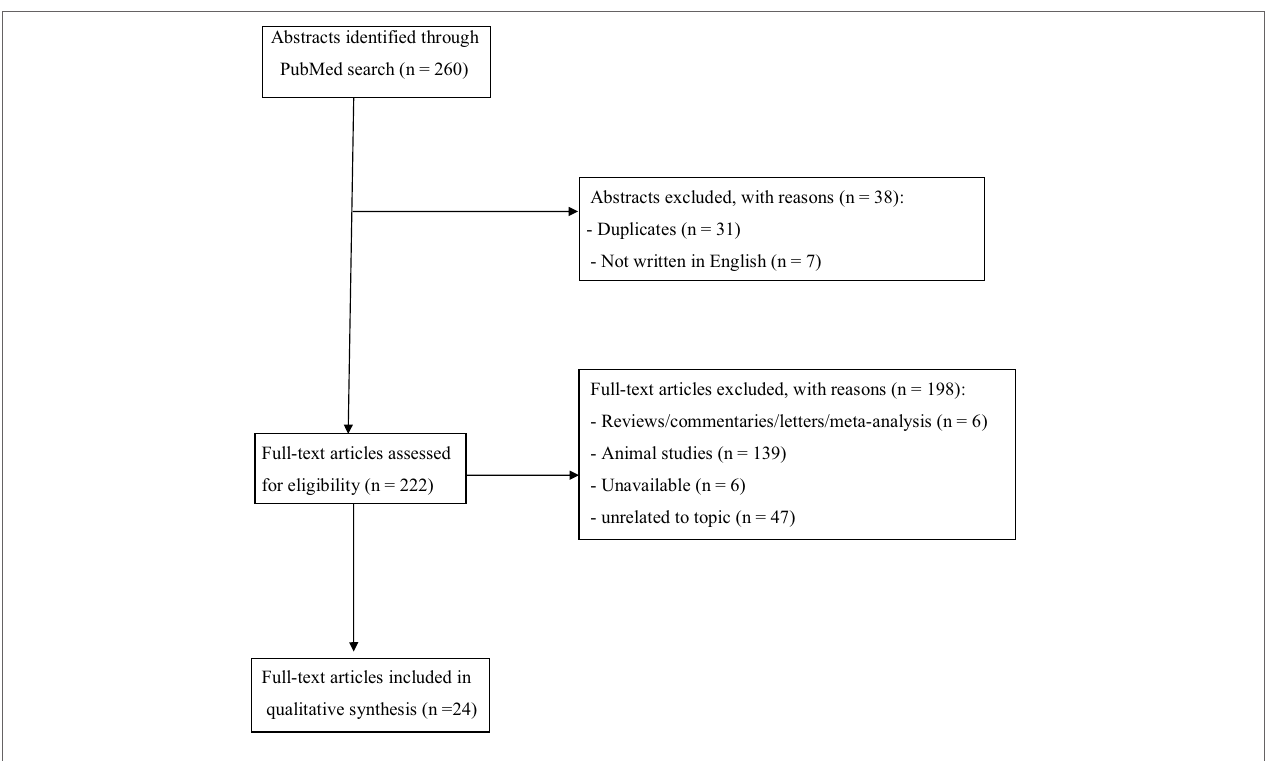
FigURe 1 | Selection of retrieved